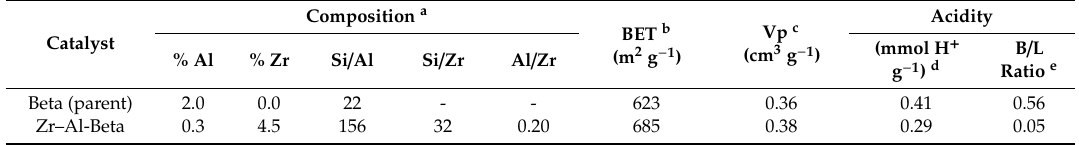
Table 1. Physicochemical properties of the parent beta and the modified Zr–Al-Beta zeolite.